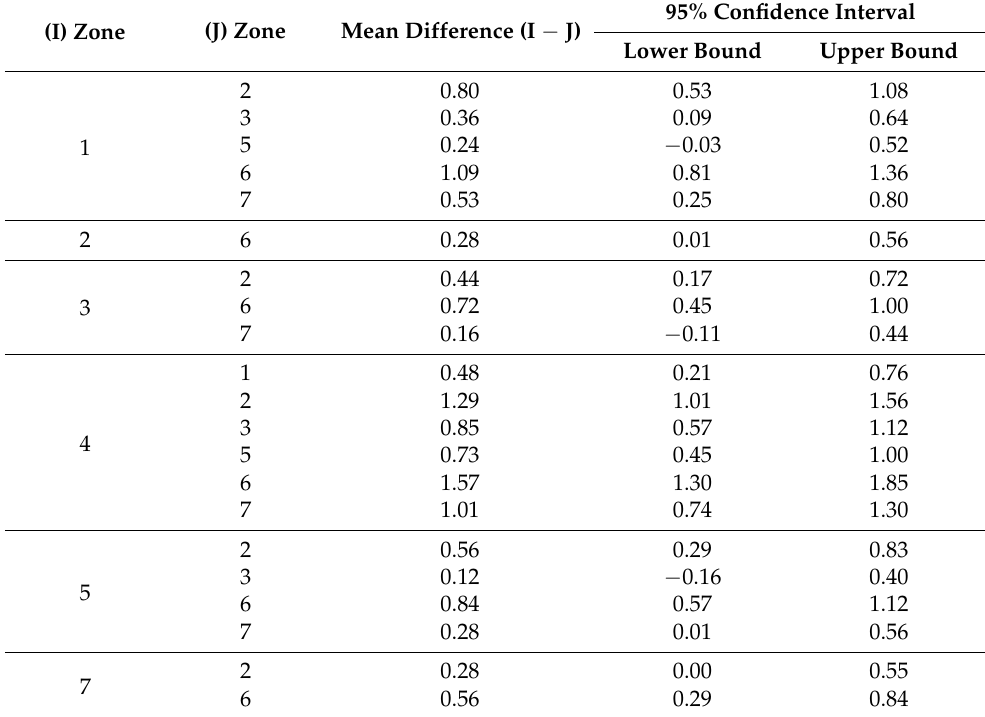
Table 4. Comparisons of mean foot skin temperature (degrees centigrade) and 95% confidence interval for zones 1–7 (see Table 1 for definitions) for both hindlimbs on three dairy farms in Morogoro ( n = 170).